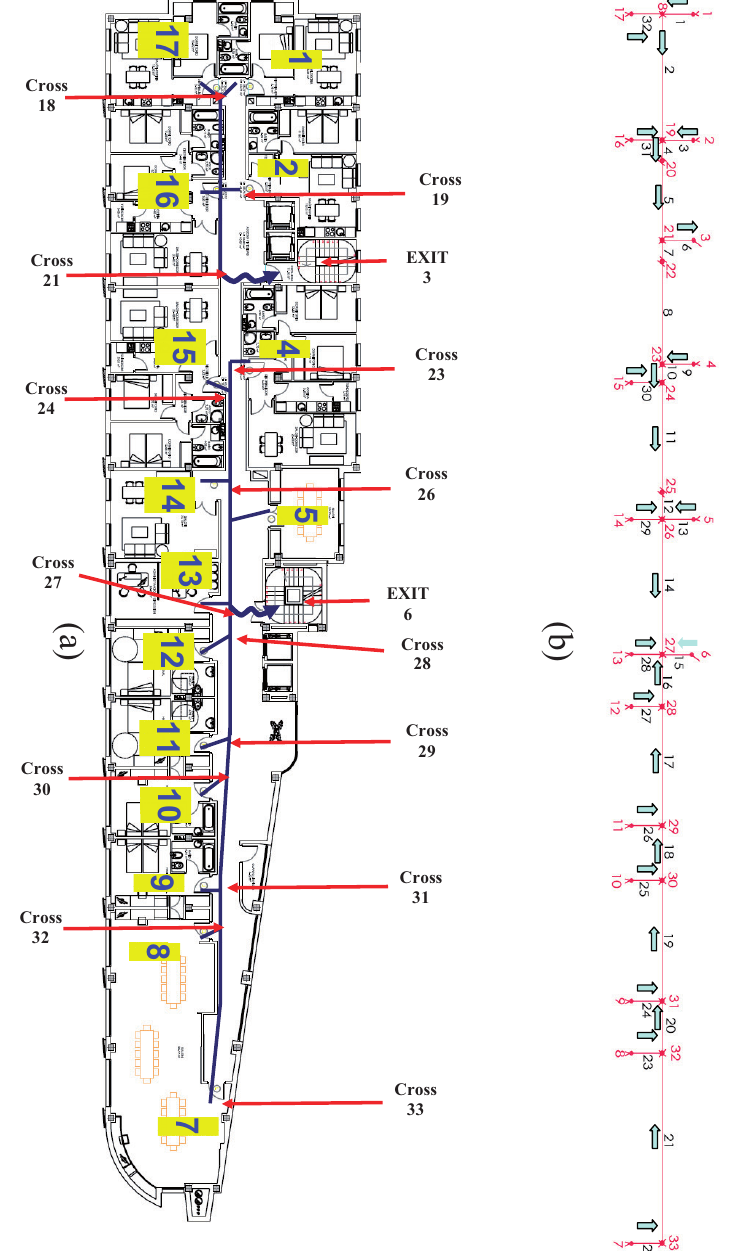
Fig. 2. Example of the layout of a hotel floor (a) and corresponding graph (b) input to the system. In the layout, the number of rooms and crossing nodes are indicated. In the graph, an example of evacuation policy is